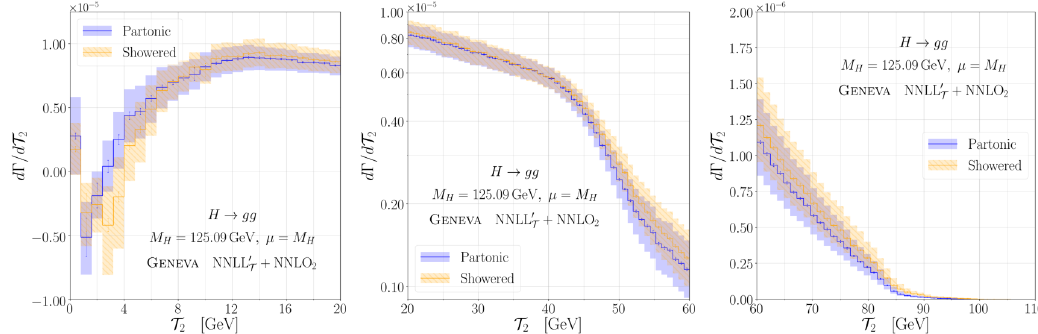
Figure 7. Validation of the T 2 spectrum in Geneva for H ! gg . The partonic NNLL 0 +NNLO T 2 resummation is compared to the showered results, before the addition of nonperturbative effects.